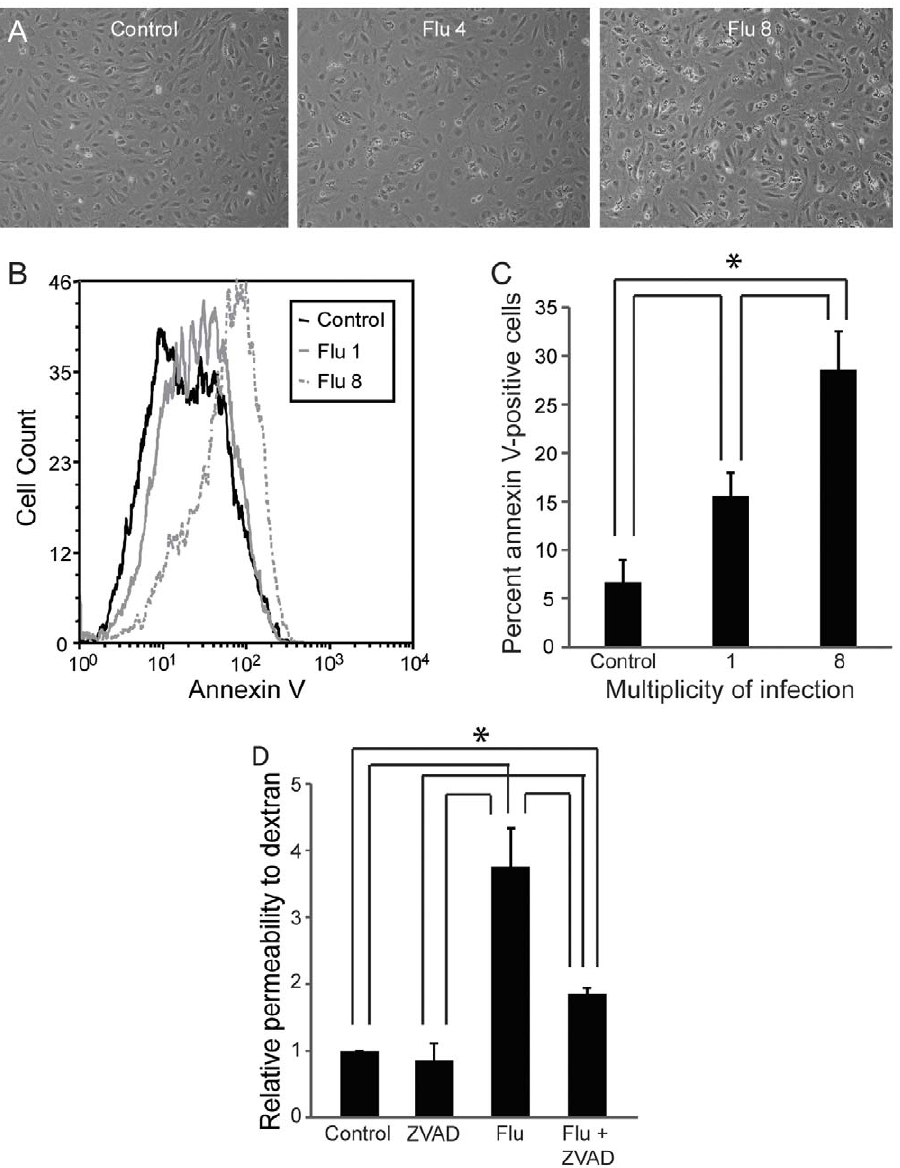
Figure 3. Human influenza induces lung endothelial apoptosis. (A) Influenza induces loss of endothelial cell viability, detected by phase contrast microscopy. Cells were infected for 24 hours at the indicated multiplicity of infection (MOI). Images were captured using a Nikon Eclipse and are representative of 3 experiments. (B) Influenza induces lung endothelial apoptosis as shown by flow cytometry. Cells were infected with influenza at the indicated MOI for 4 hours and binding of annexin V was measured. (C) The number of annexin V-positive cells increased significantly in a dose- dependent fashion. Y-axis is the percentage of cells that are positive for annexin V. Results (mean, SE) are from 4 experiments, *p , 0.05. (D) ZVAD- FMK partially prevents the induction of influenza-mediated lung endothelial permeability. Endothelial cells on transwells were infected with influenza (80 HAU/100 000 cells) for 24 hours with or without 80 m M ZVAD-FMK. Permeability to dextran was measured. Results (mean, SE) are from 4 experiments and are normalized to control, *p ,